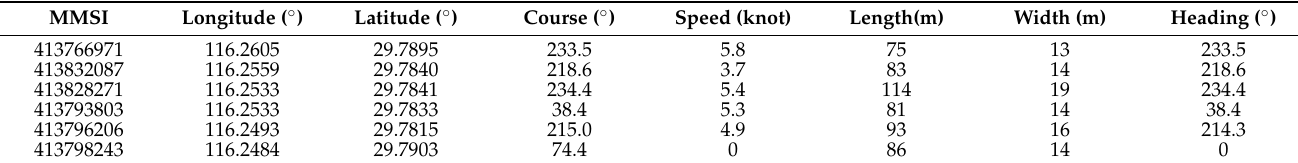
Table 8. AIS data of Case 4.